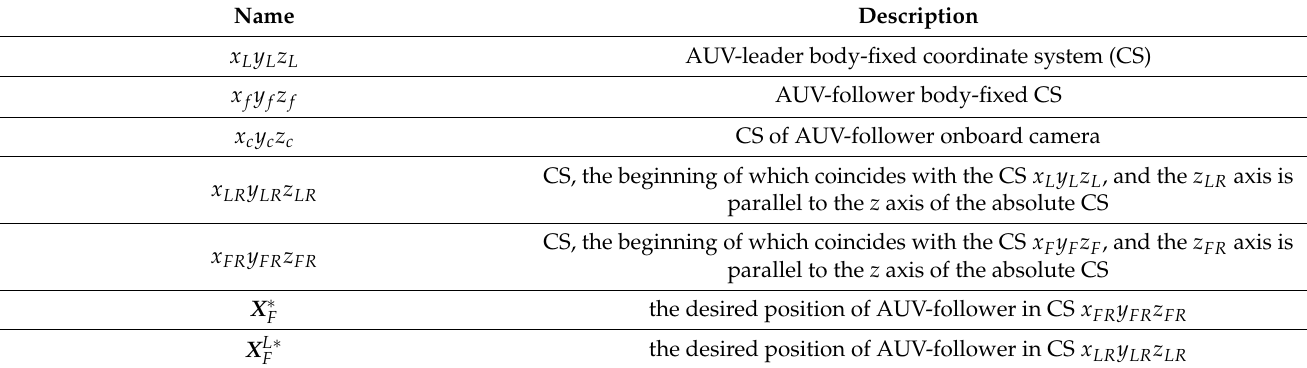
Table 1. List of